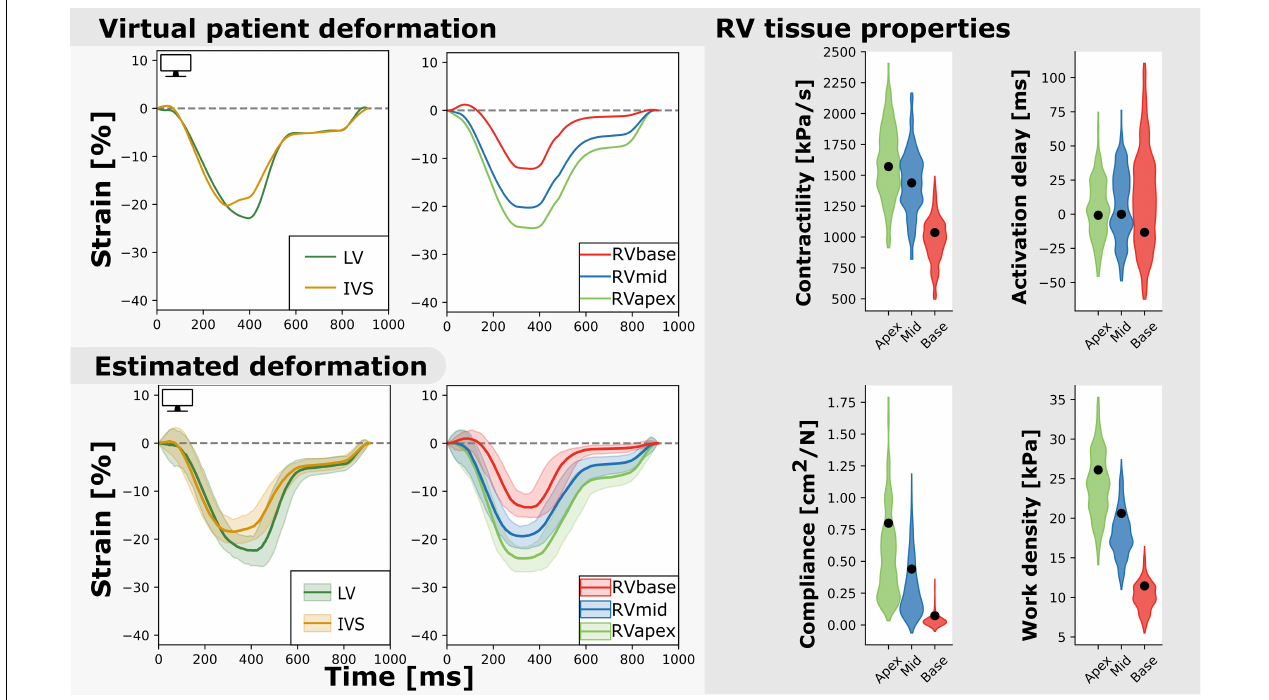
FIGURE 6 | Measured and estimated strain of virtual subject (left) and violin plots of estimated parameters (right). The estimated properties are close to the true properties of the virtual patient (black dot) and the heterogeneity is well captured. The best simulation in the sample set was closely related to the virtual patients dataset ( X 2 o pt = 2 . 0 )